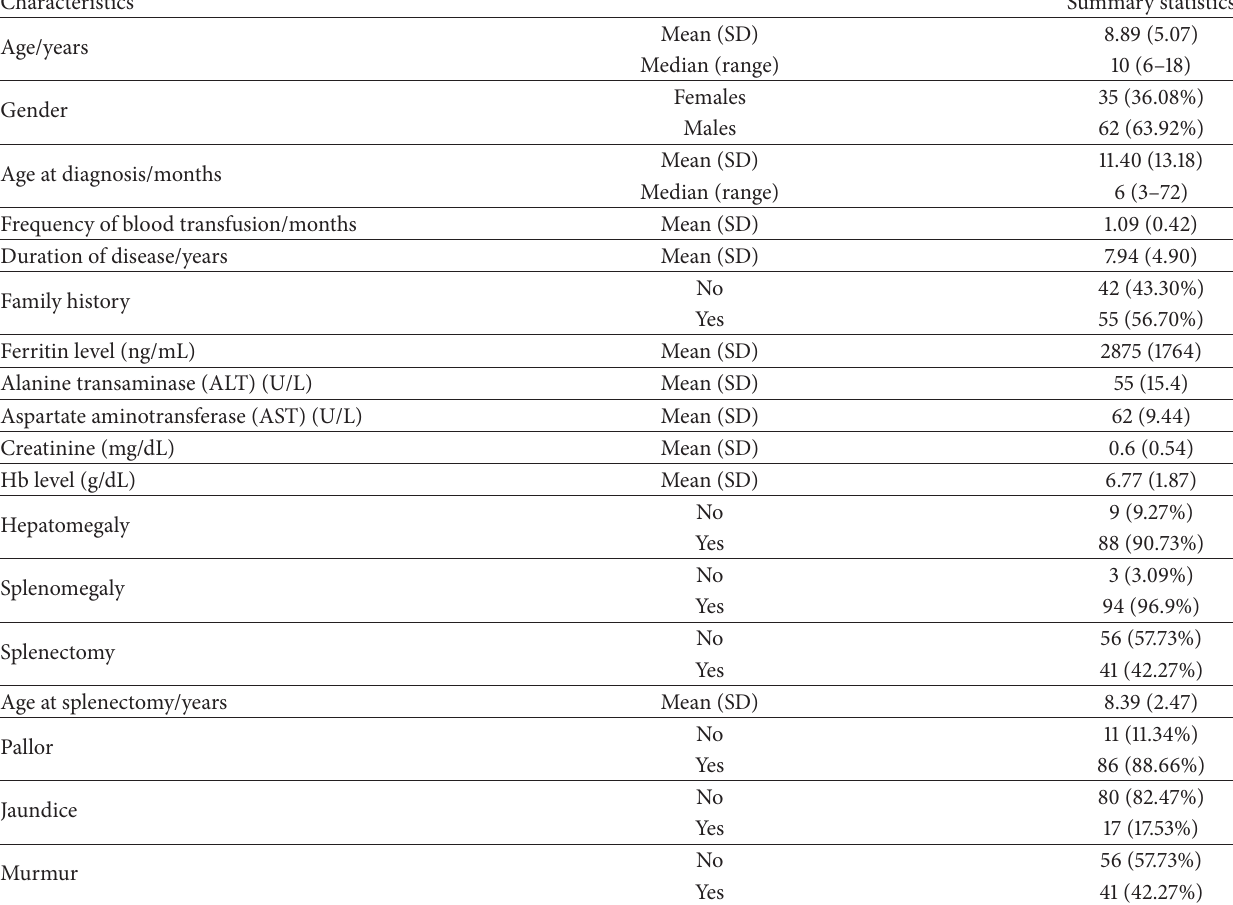
Table 1: Demographic characteristics of beta thalassemia major children.